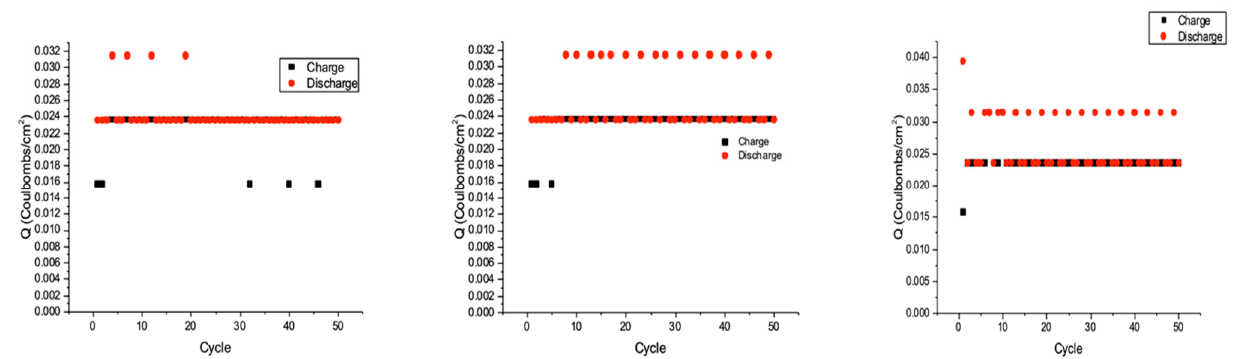
Figure 5. Coulombs versus number of cycles in charge/discharge process.